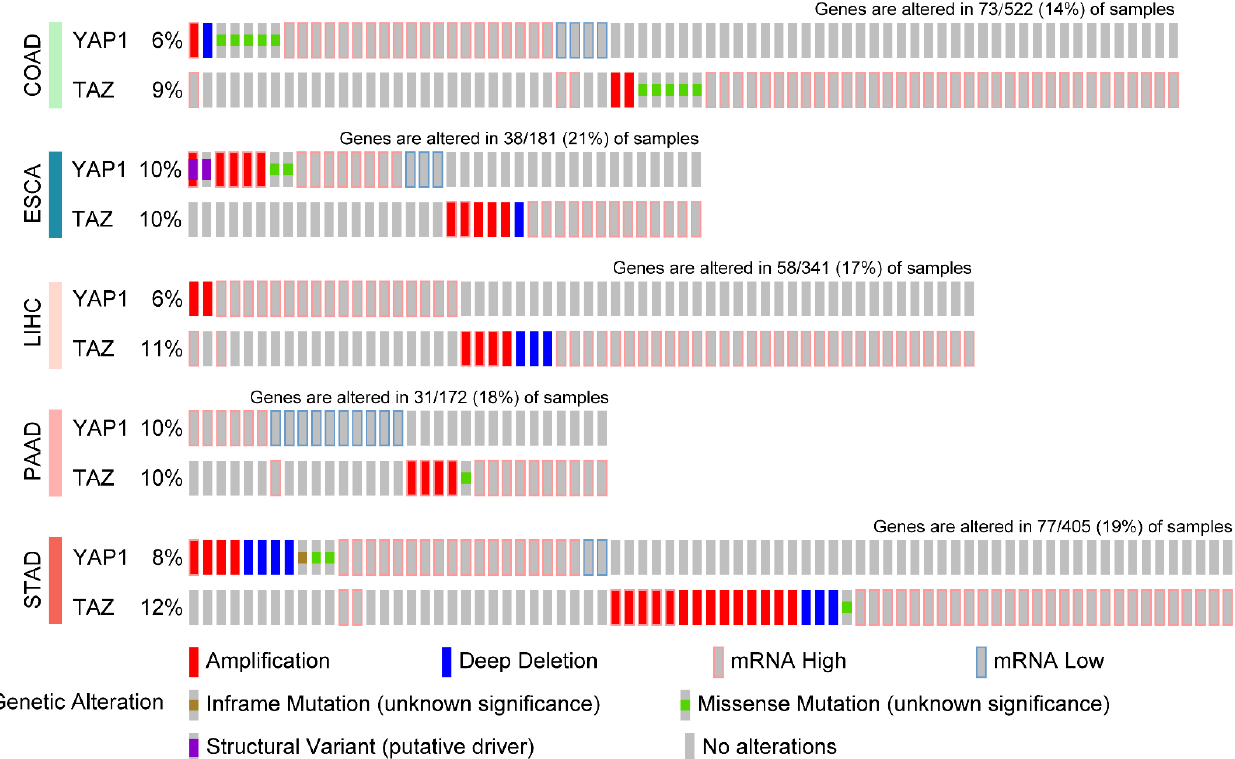
Figure 3. Genetic aberrations and mRNA upregulation of YAP1 and TAZ in gastrointestinal cancers. The TCGA PanCancer dataset illustrated the proportion of YAP1/TAZ alterations (including gene